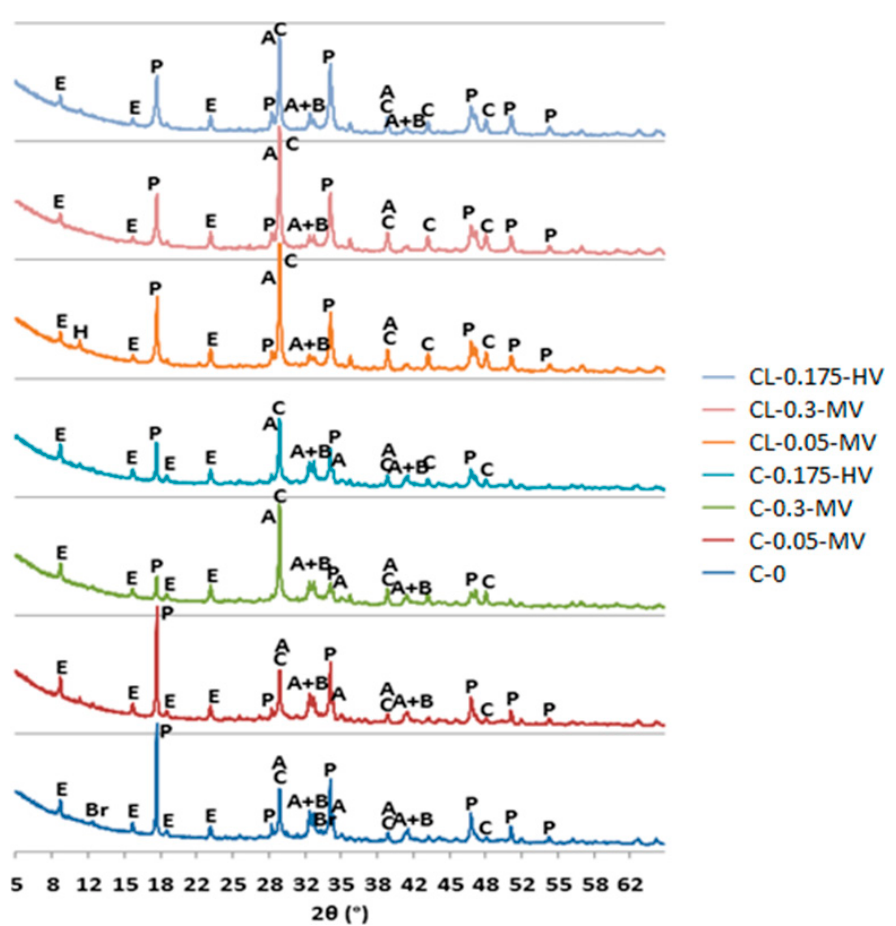
Figure 5. X-ray patterns of all pastes for 48 h. Denotation: A – alite, B – belite, Br – brownmillerit, C – calcite, E – ettringite, P – portlandite, H –